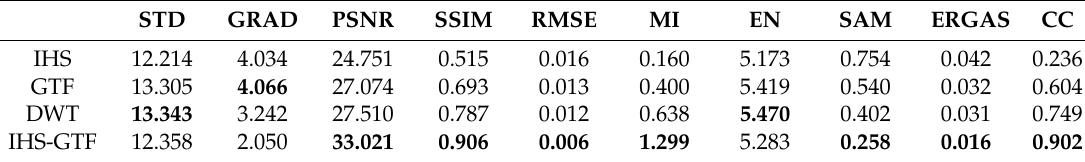
Table 3. Evaluation of fusion results for Site 2. The best results for each quality measure are in